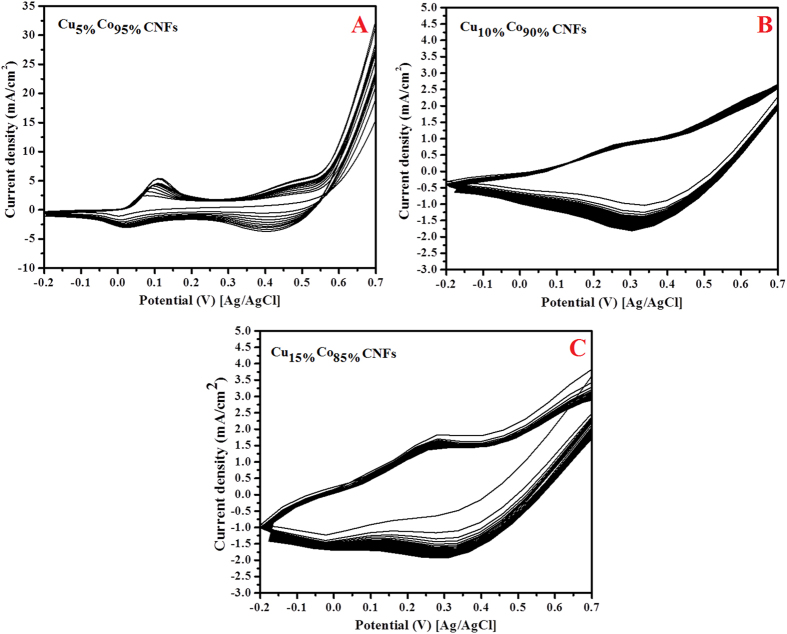
Cyclic voltammograms of the carbon nanofibers containing (A) Cu5%Co95% (B) Cu10%Co90% and (C) Cu15%Co85% formulations in 1 M KOH. Scan rate 100 mV/s.